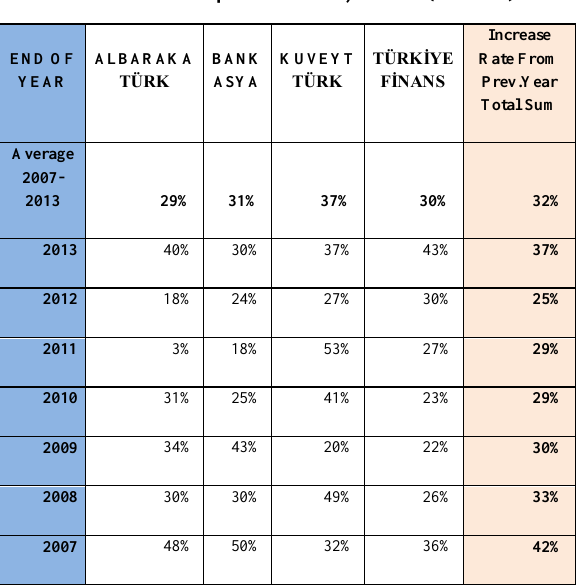
Table-16/b: Increase Rate from Previous Year at Total Assets in Participation